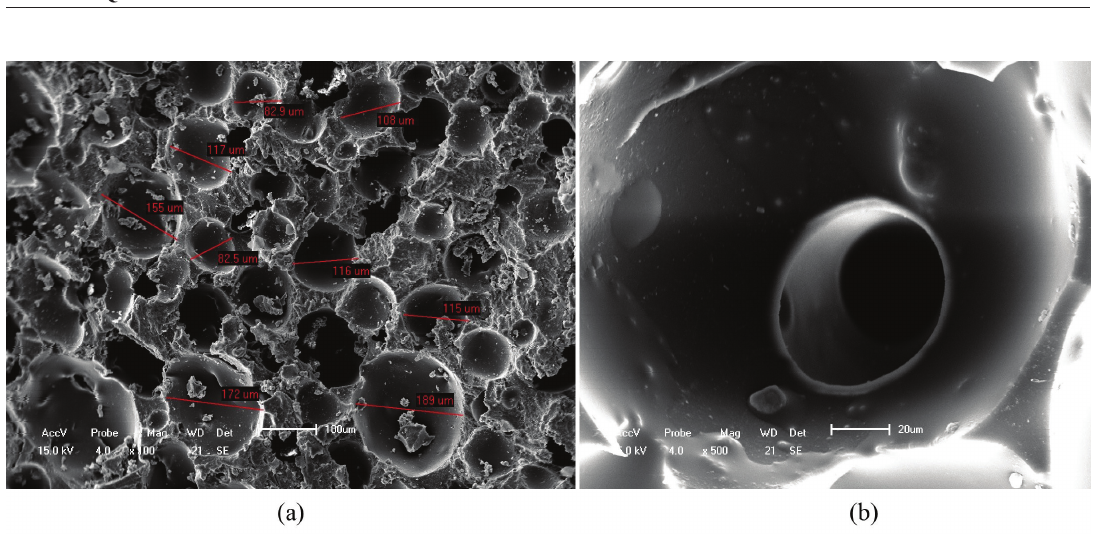
Figure 2. PUGQ agglomerate micrograph (a) 100X and (b)